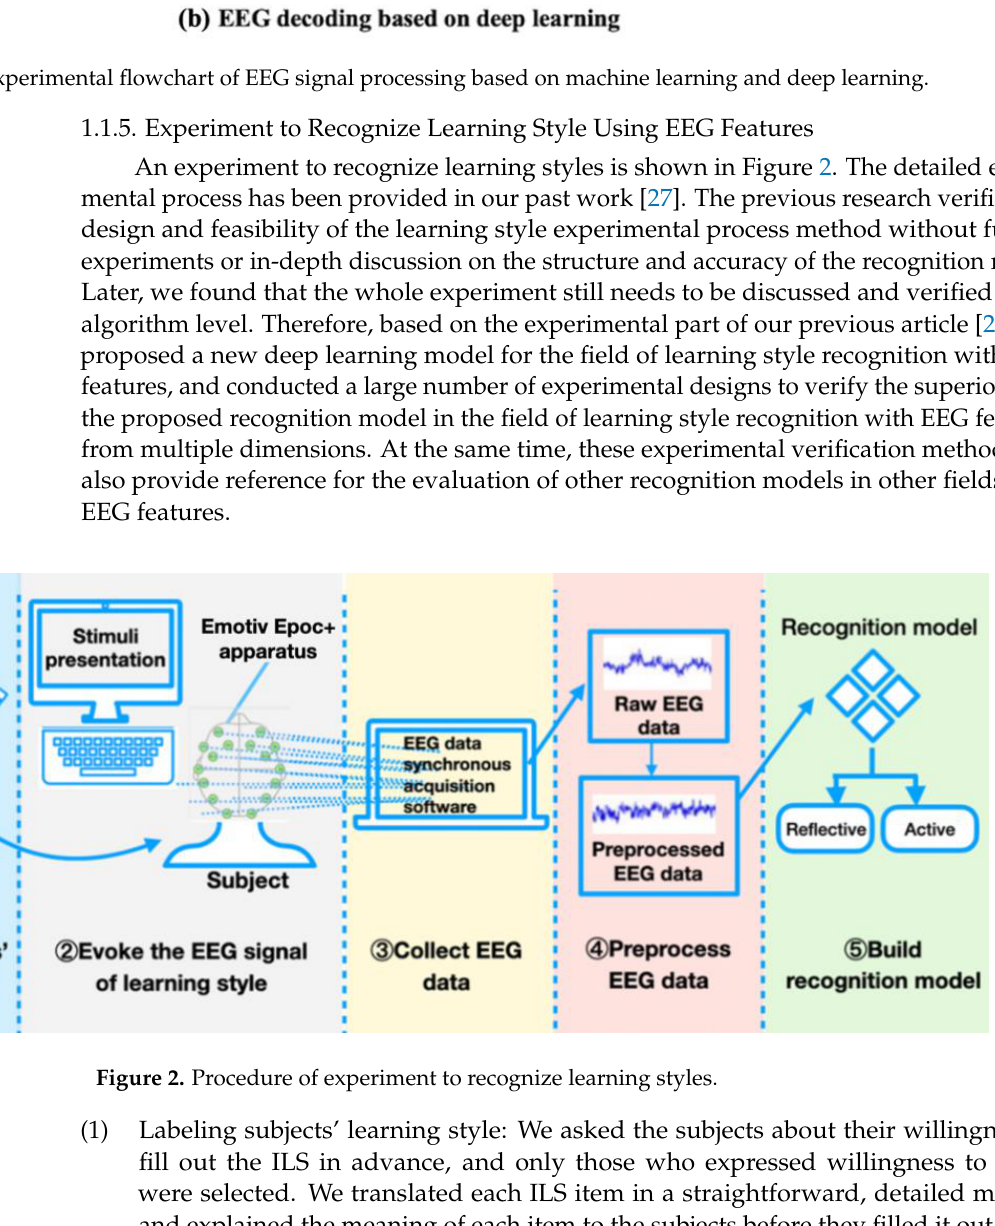
Figure 1. Experimental flowchart of EEG signal processing based on machine learning and deep learning.